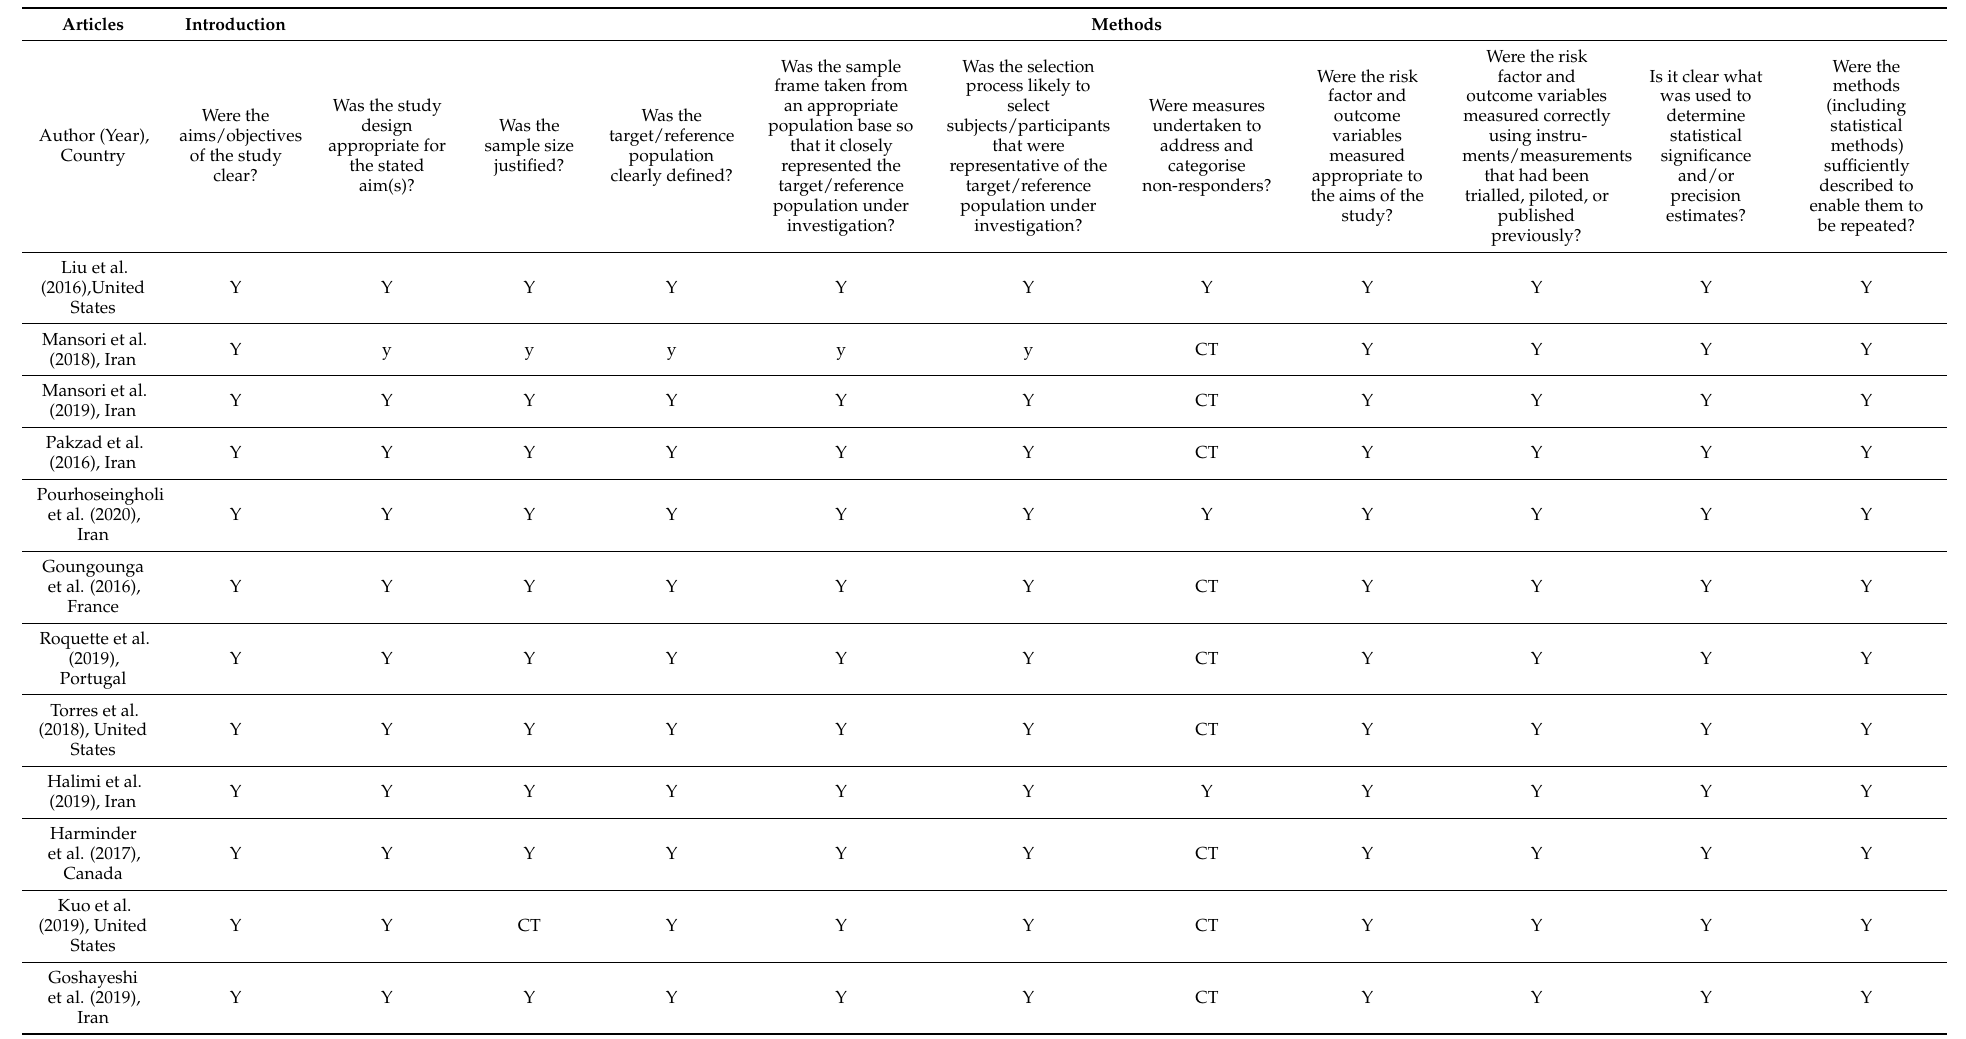
Table 2. Quality assessment of included studies using AXIS